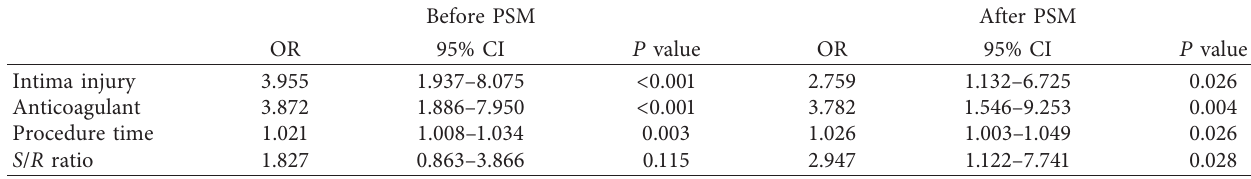
Table 3: Independent predictors of radial artery thrombosis by multivariate logistic